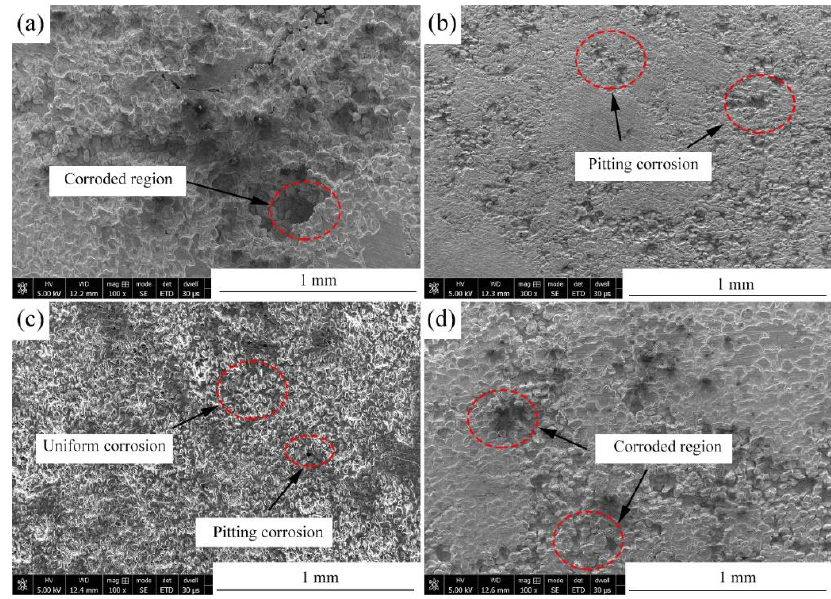
Figure 13. Corrosion morphologies of the four-pass extrusion alloys after 14 days of immersion in Hank’s solution with removal of the corrosion products: ( a ) Mg-2Zn-0.5Zr alloy; ( b ) Mg-2Zn-0.5Gd- 0.5Zr alloy; ( c ) Mg-2Zn-0.5Nd-0.5Zr alloy; and ( d ) Mg-2Zn-0.5Y-0.5Zr alloy.